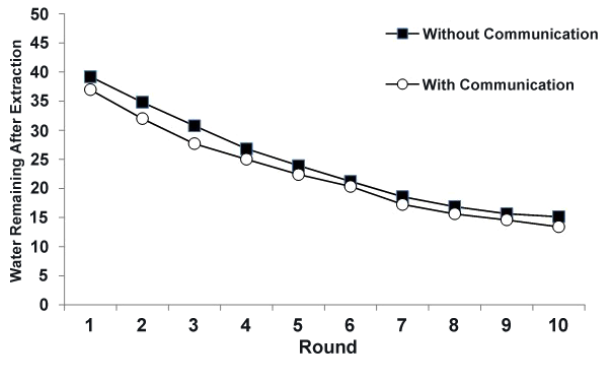
Fig. 3. Average amount of water remaining after extraction for the 34 participant groups in games without participant communication and with communication after each round.